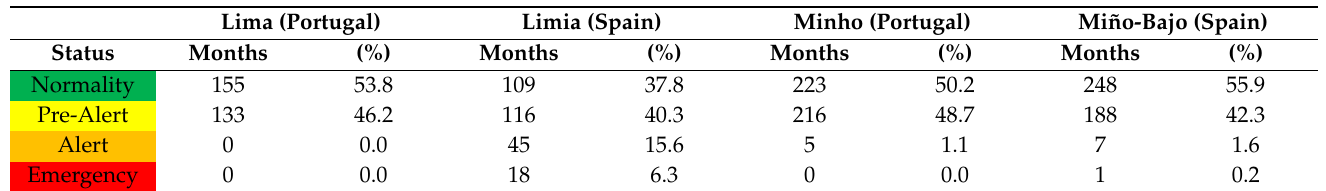
Table 2. Distribution of the scarcity status in the Portuguese and Spanish parts of the Lima and Minho river basin.